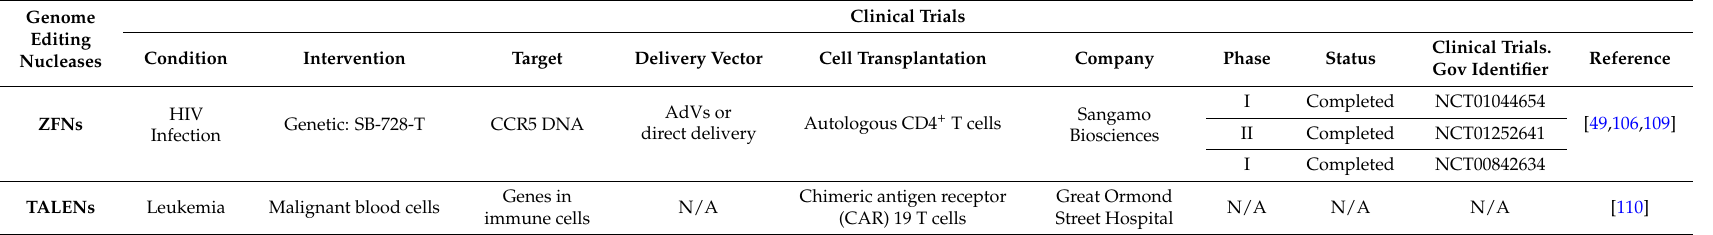
Table 3. Nuclease-mediated genome editing technologies having been used in clinical